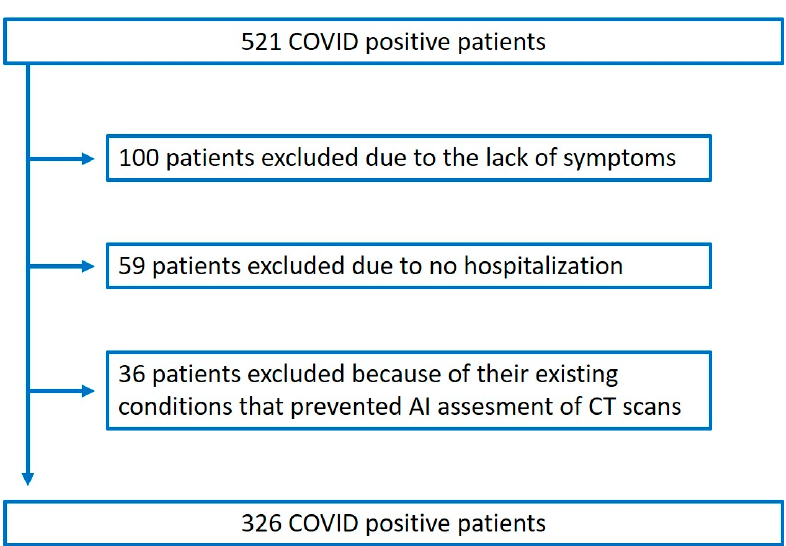
Figure A1. Study flowchart.